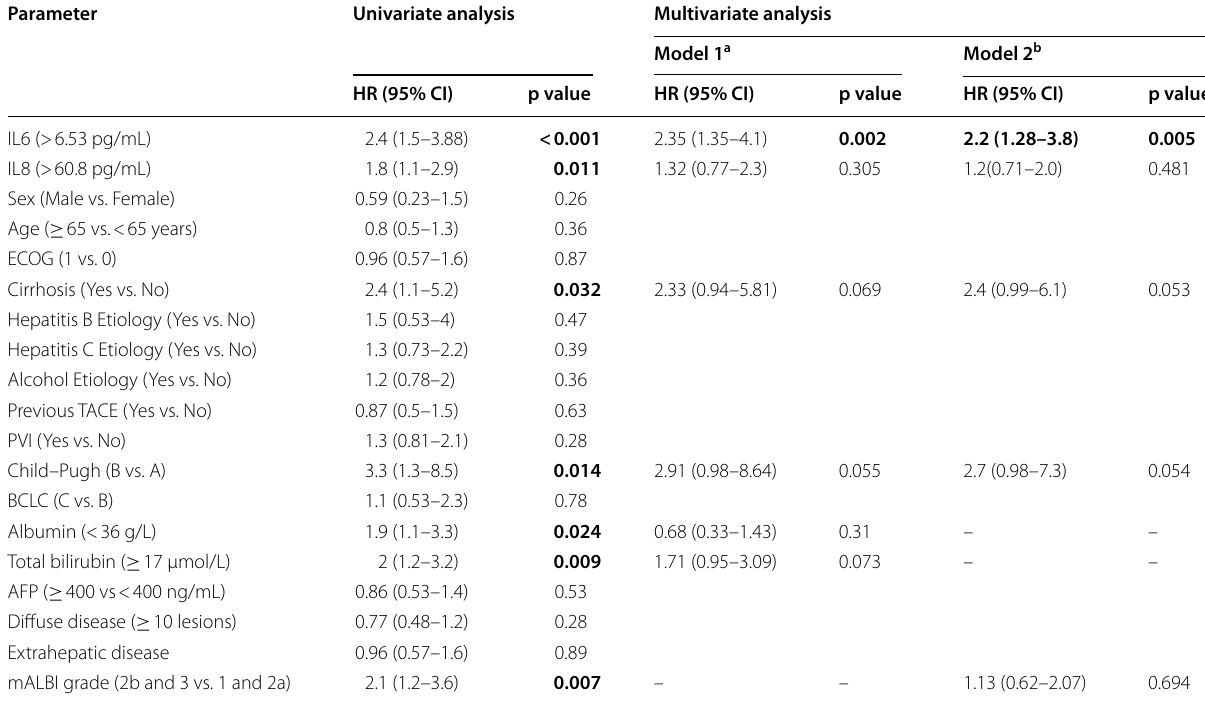
Table 2 Univariate and multivariate analysis of factors associated with overall